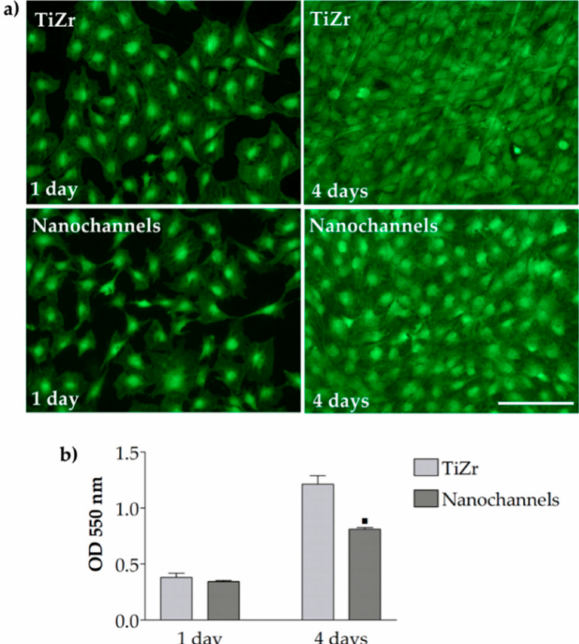
Figure 5. ( a ) Fluorescent images of the MC3T3-E1 cells grown for 1 and 4 days in contact with flat and nanochannelar substrates after staining with the Live/Dead Cell Viability/Cytotoxicity Assay Kit (live cells are green stained). Scale bar represents 200 µ m; ( b ) Proliferation of MC3T3-E1 pre-osteoblasts as assessed by MTT assay. Data analysis was based on mean ± standard error of the mean (SEM) ( n = 3); p < 0.05 vs.